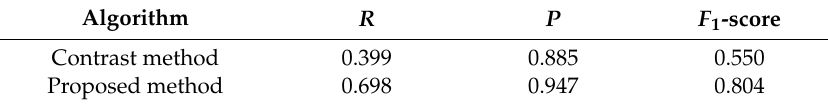
Table 2. Comparison of the indices of the center recognition results.